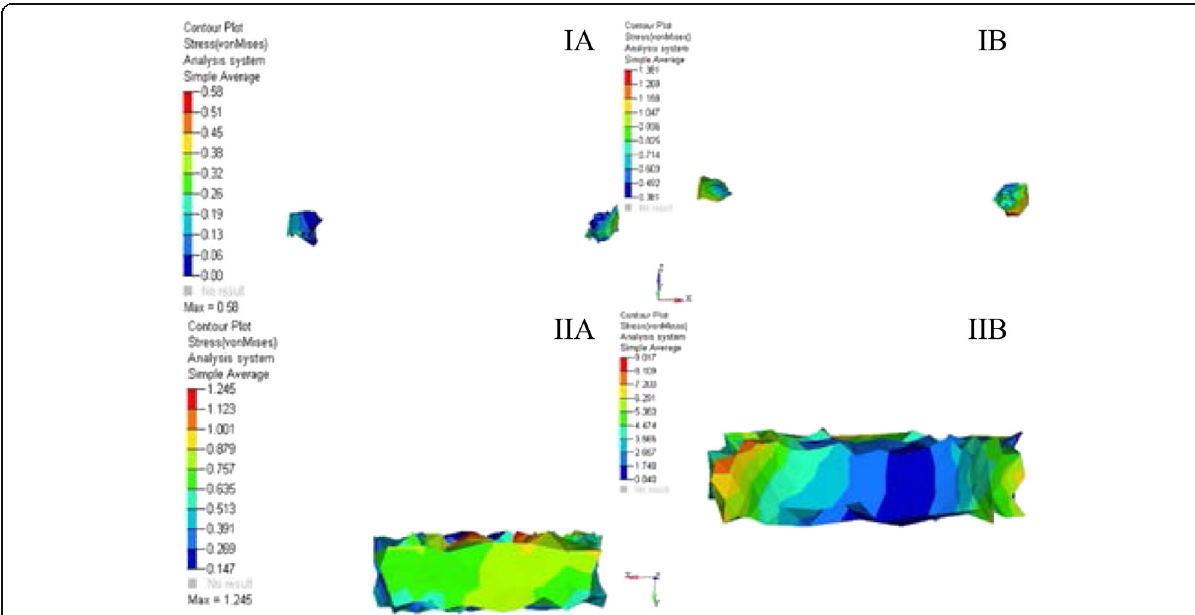
Fig. 9 von Mises stresses at different sutures for A RME. B Implant-supported RME. IA , IB Zygomatico-frontal suture. IIA , IIB Spheno-occipital synchondrosis